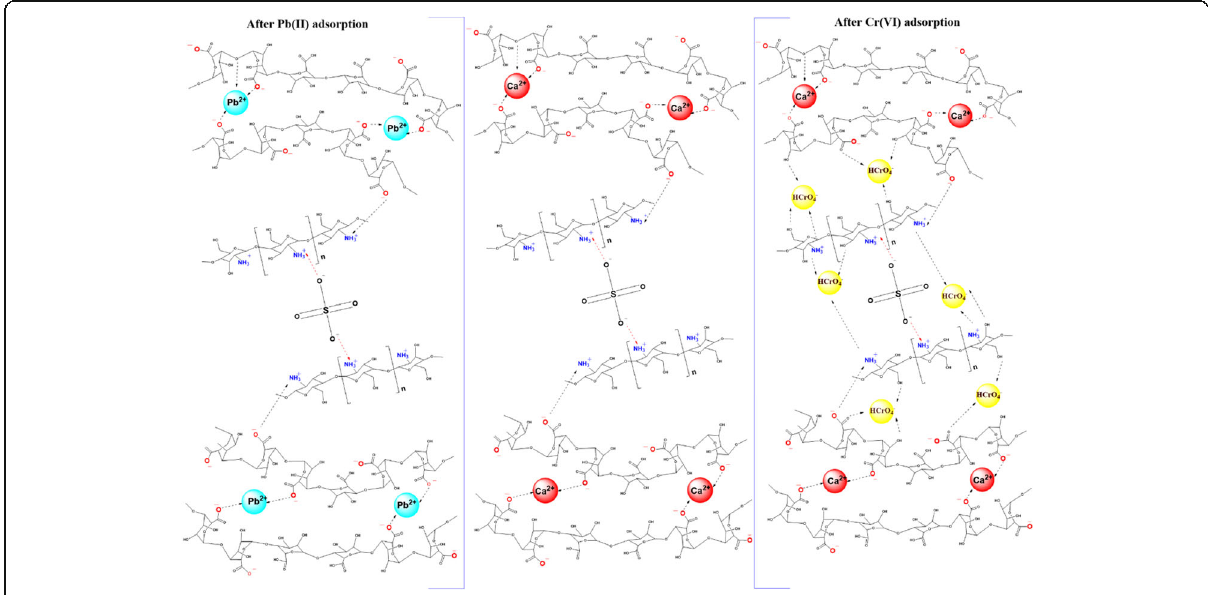
Fig. 5 Proposed mechanism of adsorption of Cr(VI) and Pb(II) ions onto CSM/SA hybrid